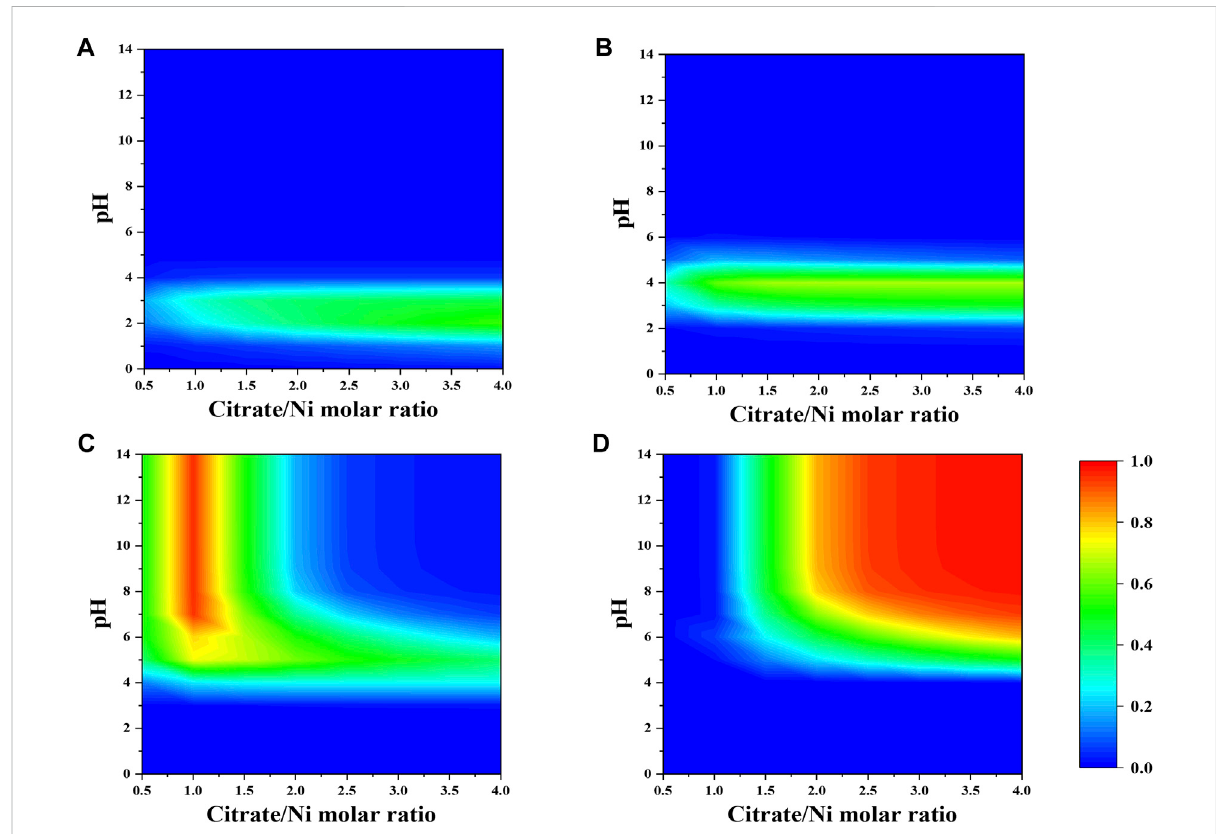
FIGURE 1 Fraction of nickel-citrate complexes (A) NiH 2 Cit + , (B) NiHCit, (C) NiCit − , and (D) NiCit 2 4- as a function of citrate-to-nickel molar ratio and pH in the absence of